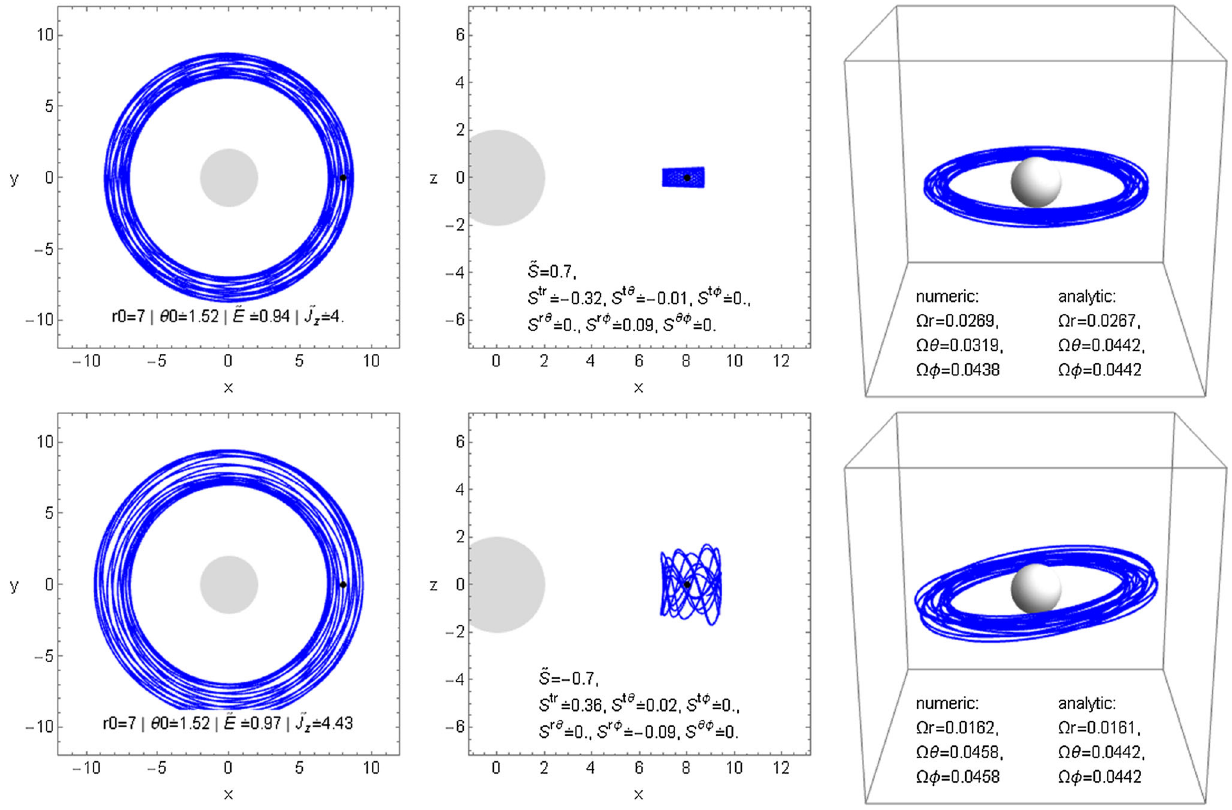
Fig. 3 Perturbed circular orbit for spinning particles around Schwarzschild BH; numerical frequencies (from trajectory Fourier spectra) and analytical frequencies (Eqs. 18–20) are given. Numerical and analytical frequencies are identical for exactly circular orbit only,